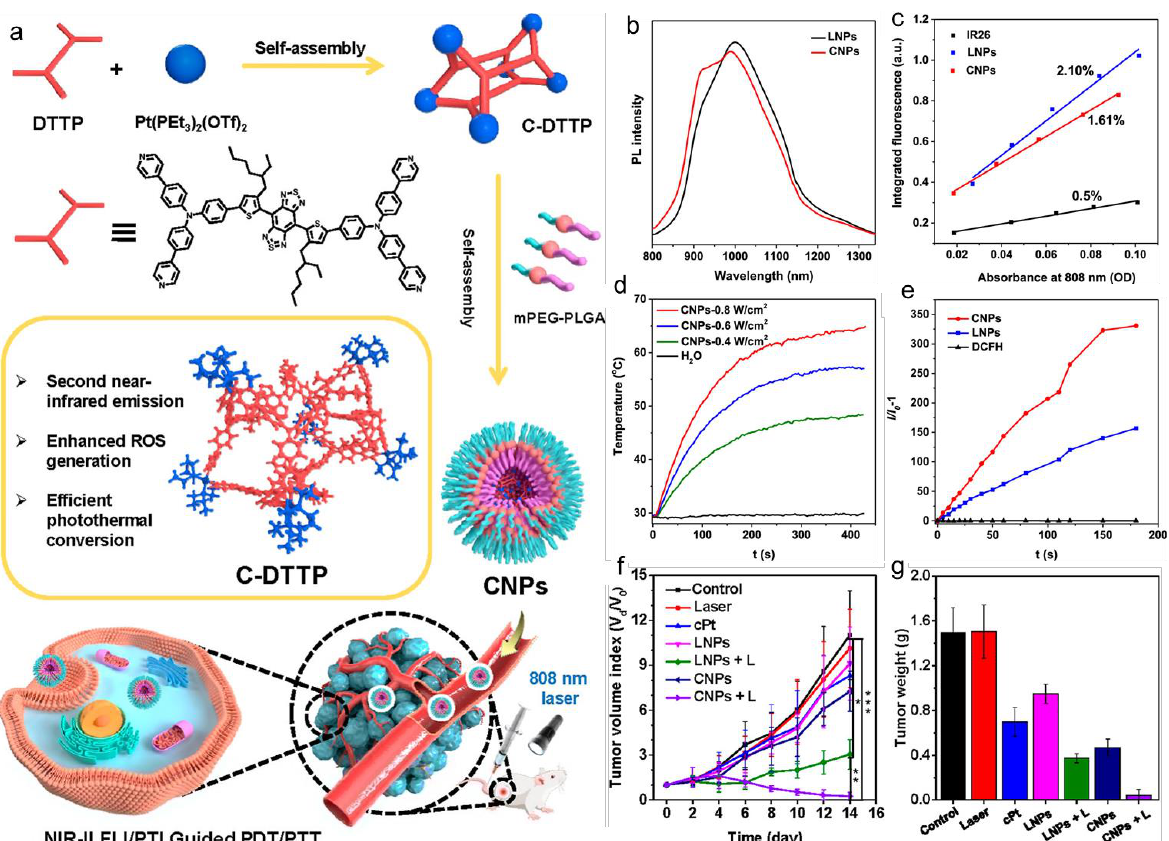
Figure 10. ( a ) Schematic illustration of the supramolecular coordination complex C-DTTP NPs for NIR-II fluorescence imaging-guided PDT and PTT. ( b ) PL spectra, ( c ) measurements of fluorescence QY, ( d ) photothermal curves, and ( e ) ROS generation of various NPs. ( f ) Relative tumor volumes and ( g ) tumor weights of MDA-MB-231 tumor-bearing BALB/c nude mice after different